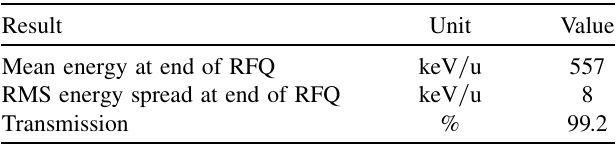
TABLE XV. Output results for C 6 þ RFQ simulations.